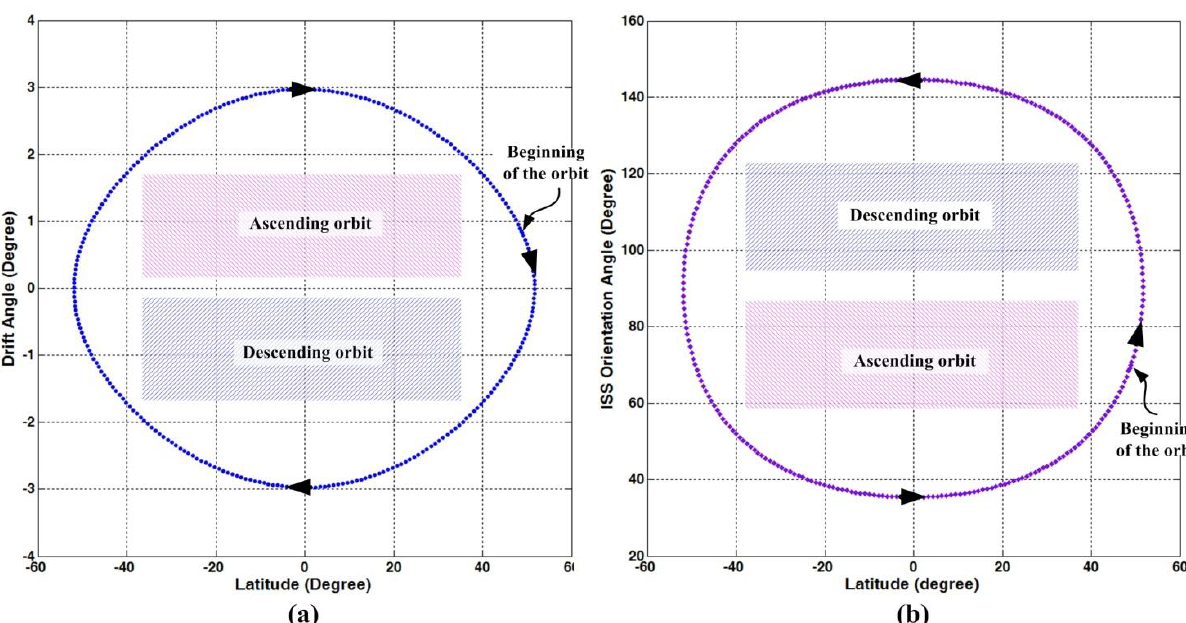
Figure 6. The changes of the ( a ) ISS drift angle and ( b ) orientation angle in one complete orbit. The ISS orbital data used in estimating these two angles were extracted from the ISS Broadcast Ancillary Data (BAD) packages from a time period from 2008:320:00:00:00 (yyyy:ddd:hh:mm:ss) to 2008:320:01:31:40 (a little more than one orbit cycle of the ISS) at an interval of 20